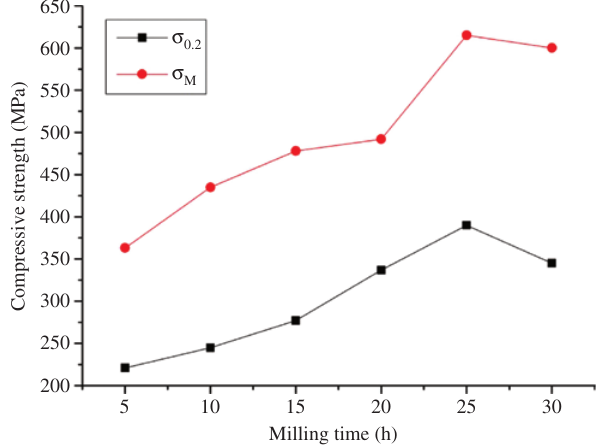
alloy at room 2